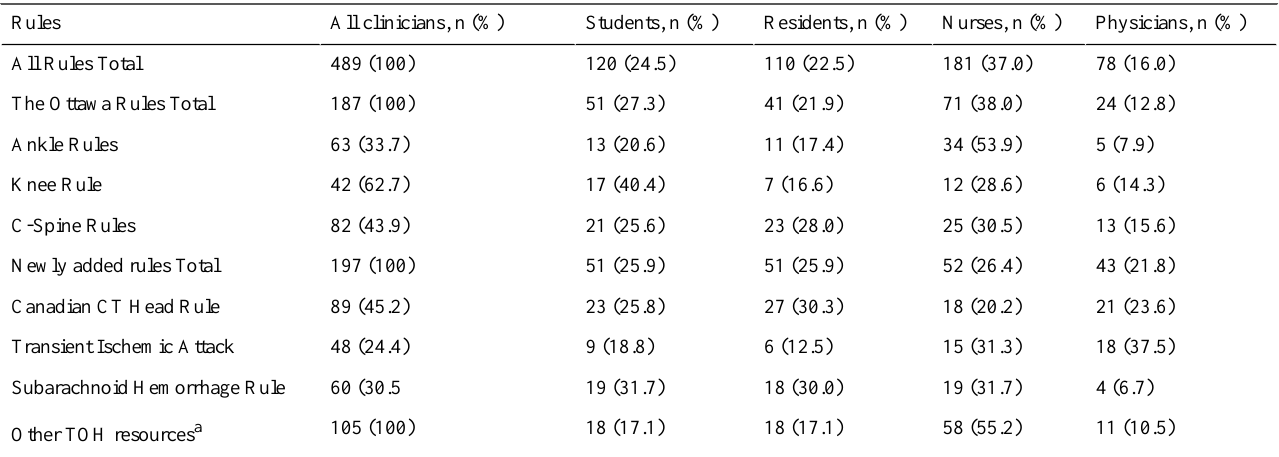
Table 2. Study user app engagement stratified by content accessed and clinician